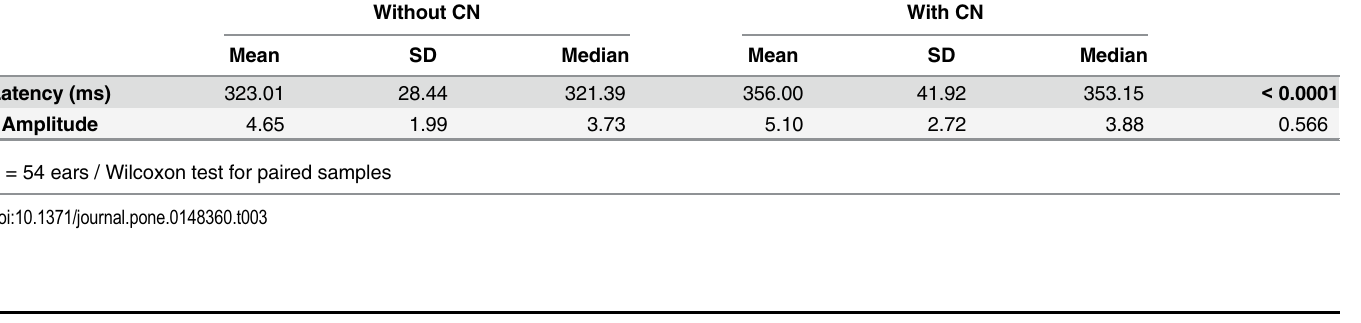
Table 3. Comparison between the conditions with and without noise for P300 latency (ms) and amplitude ( μ V) values. Without CN With